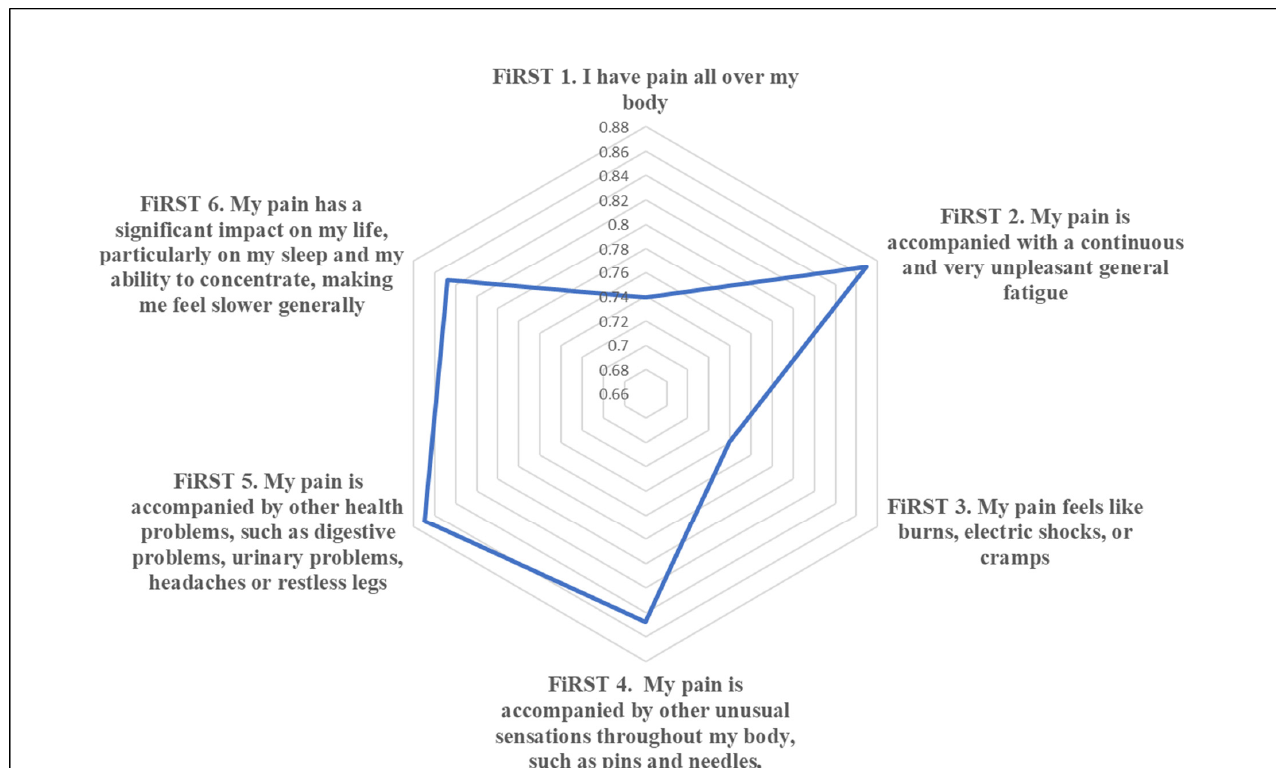
Figure 3. Radar chart for FiRST survey items of the 46 participants.